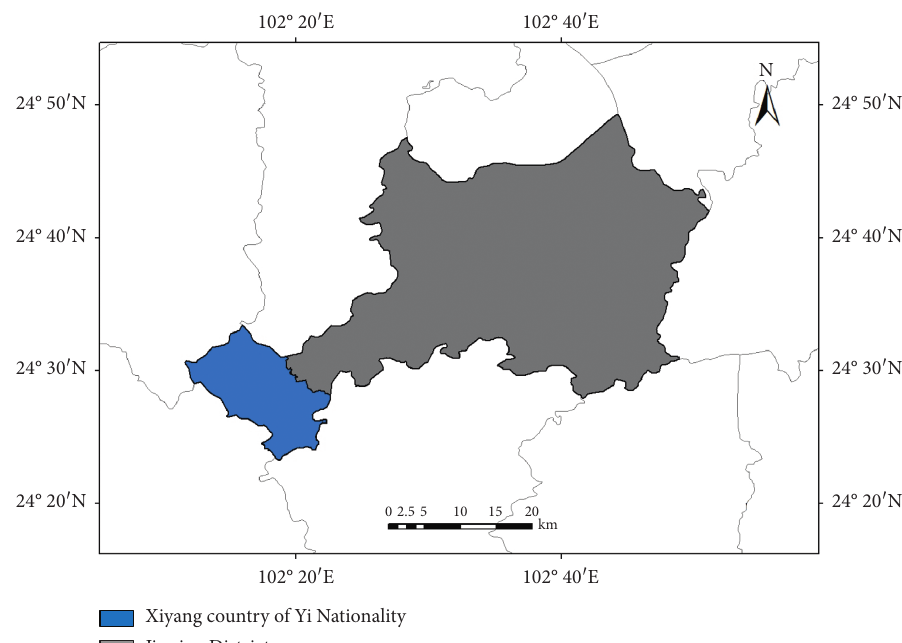
Figure 1: Geographical situation of the study